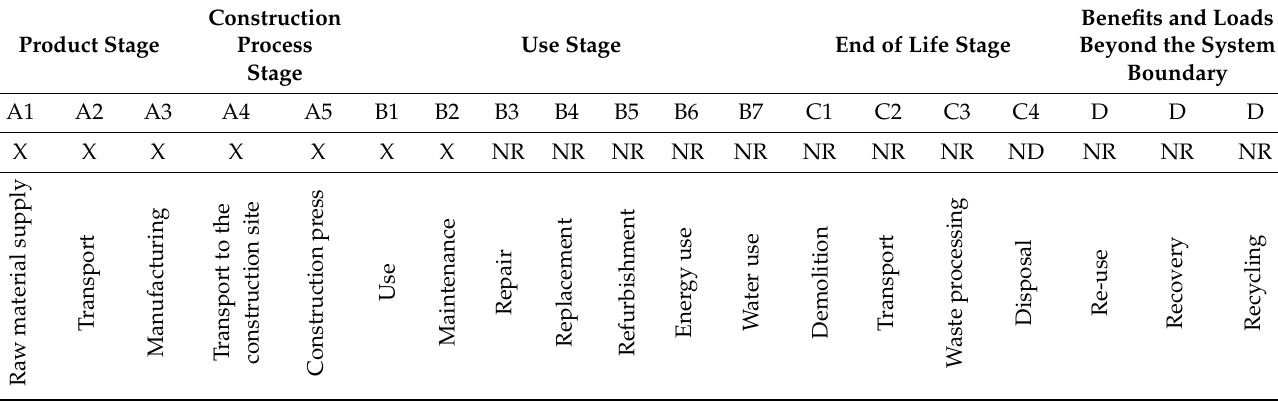
Table 2. Scope of the LCA, system limit